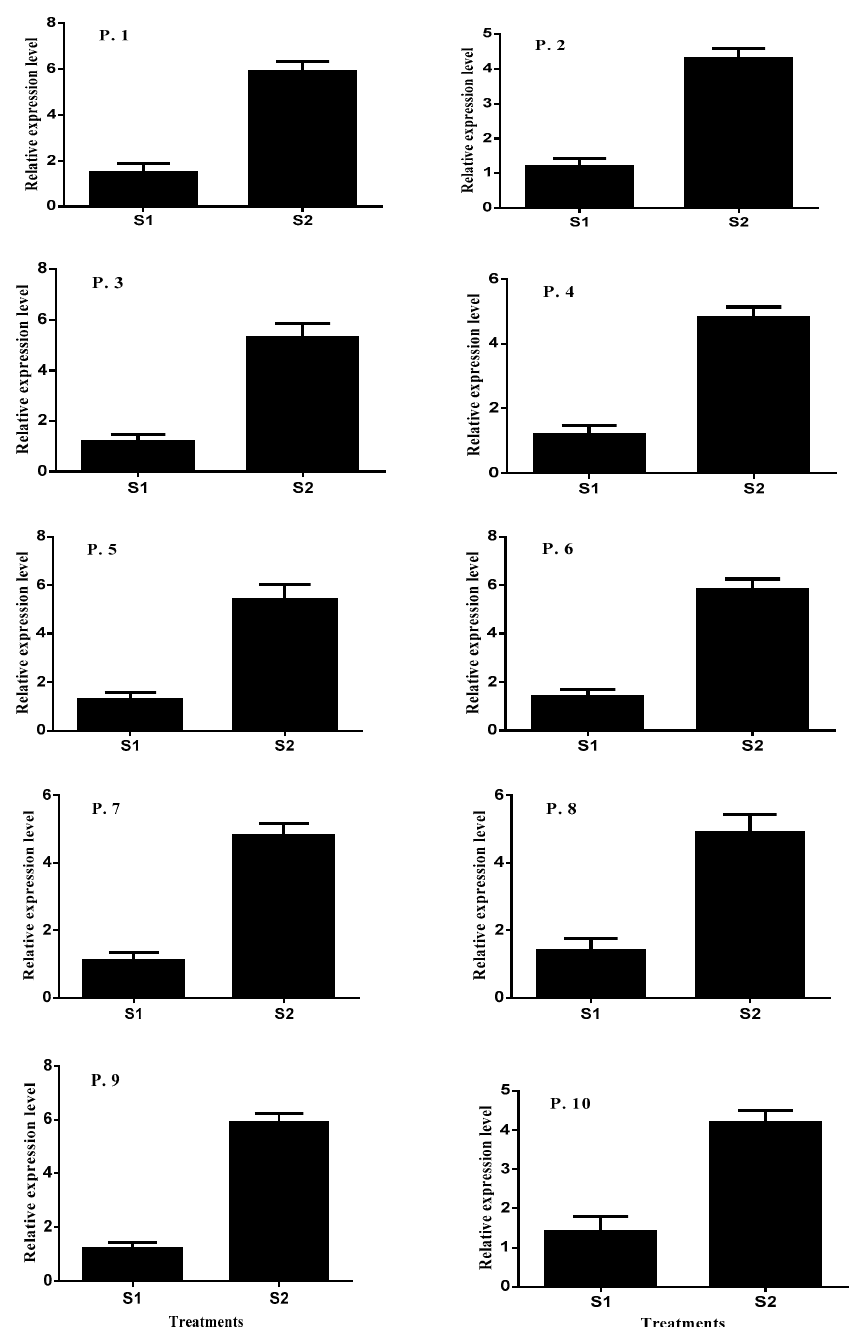
Figure 6. Relative expression levels of AeNHX1 in leaves of Ae. tauschii populations under salinity conditions. Actin was used as an internal reference. Experiments were repeated three times. Values are means, and bars indicate standard deviation (SD). (S1 = 50 mM NaCl and S2 = 200 mM NaCl and P. = population) .